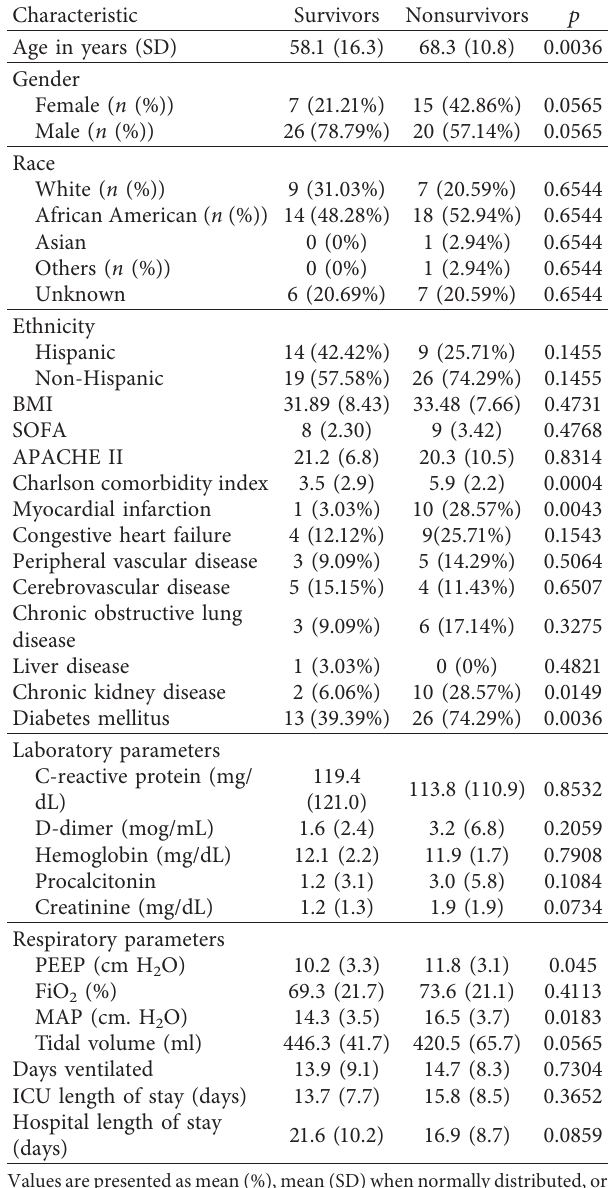
Table 1: Clinical characteristics of the COVID-19 patients with acute hypoxic respiratory failure requiring